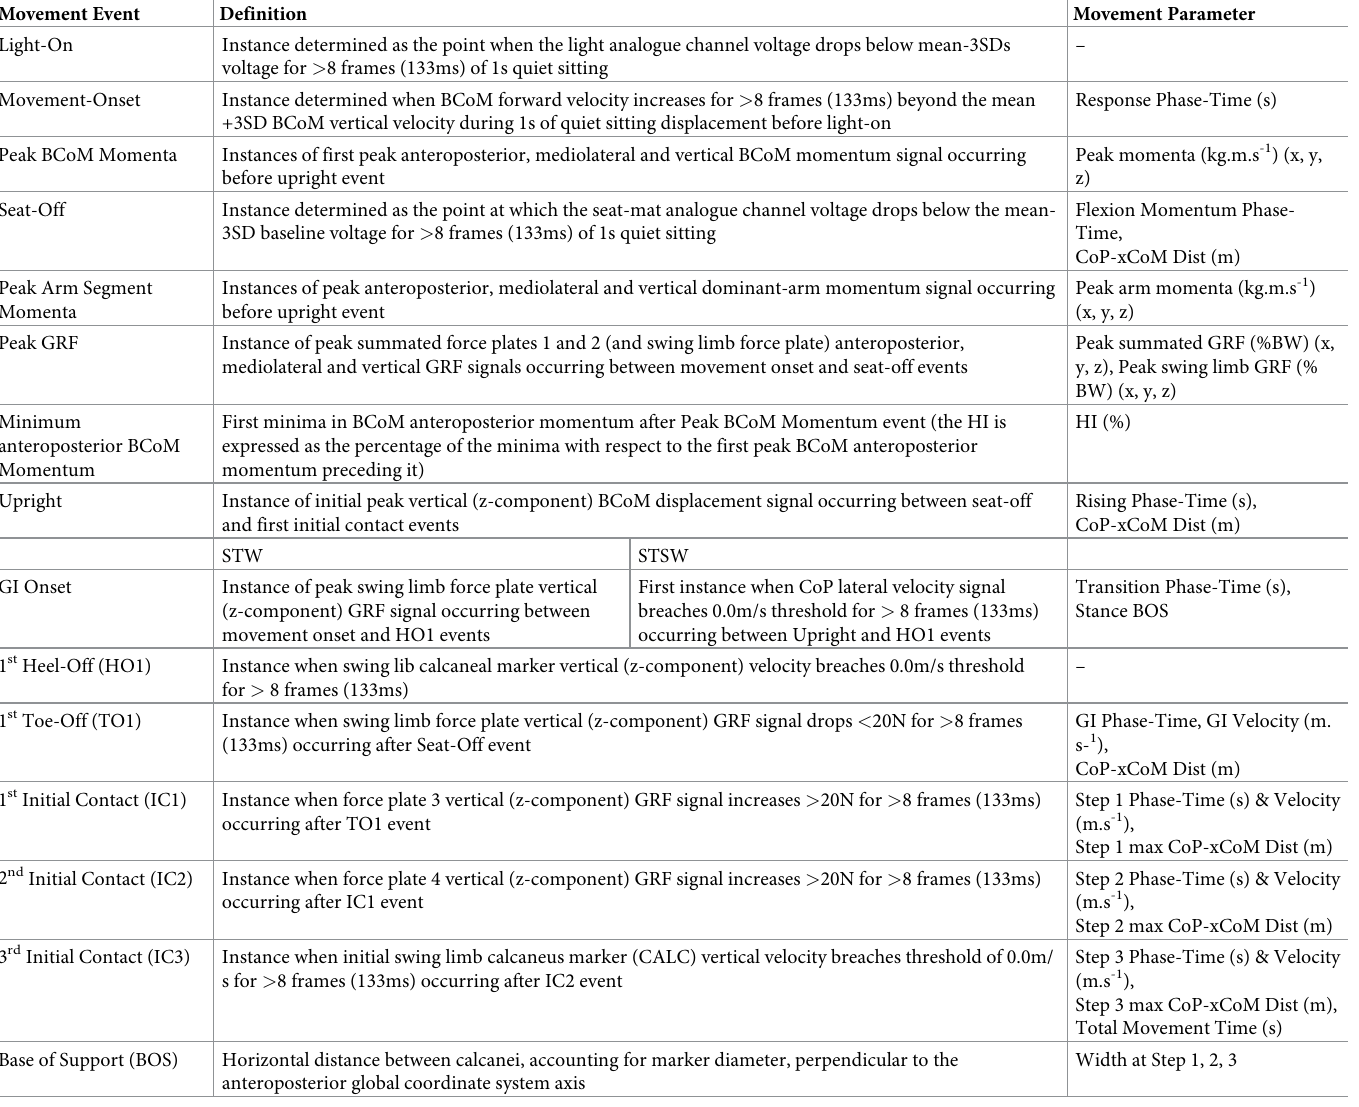
Table 1. Definintion of movement events during STW and